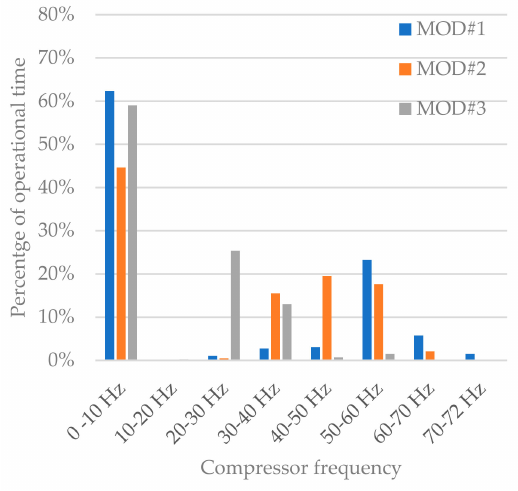
Figure 8. Typical mild ( left ) and colder ( right ) days under MOD#3 (25-Jan., 5-Feb.).